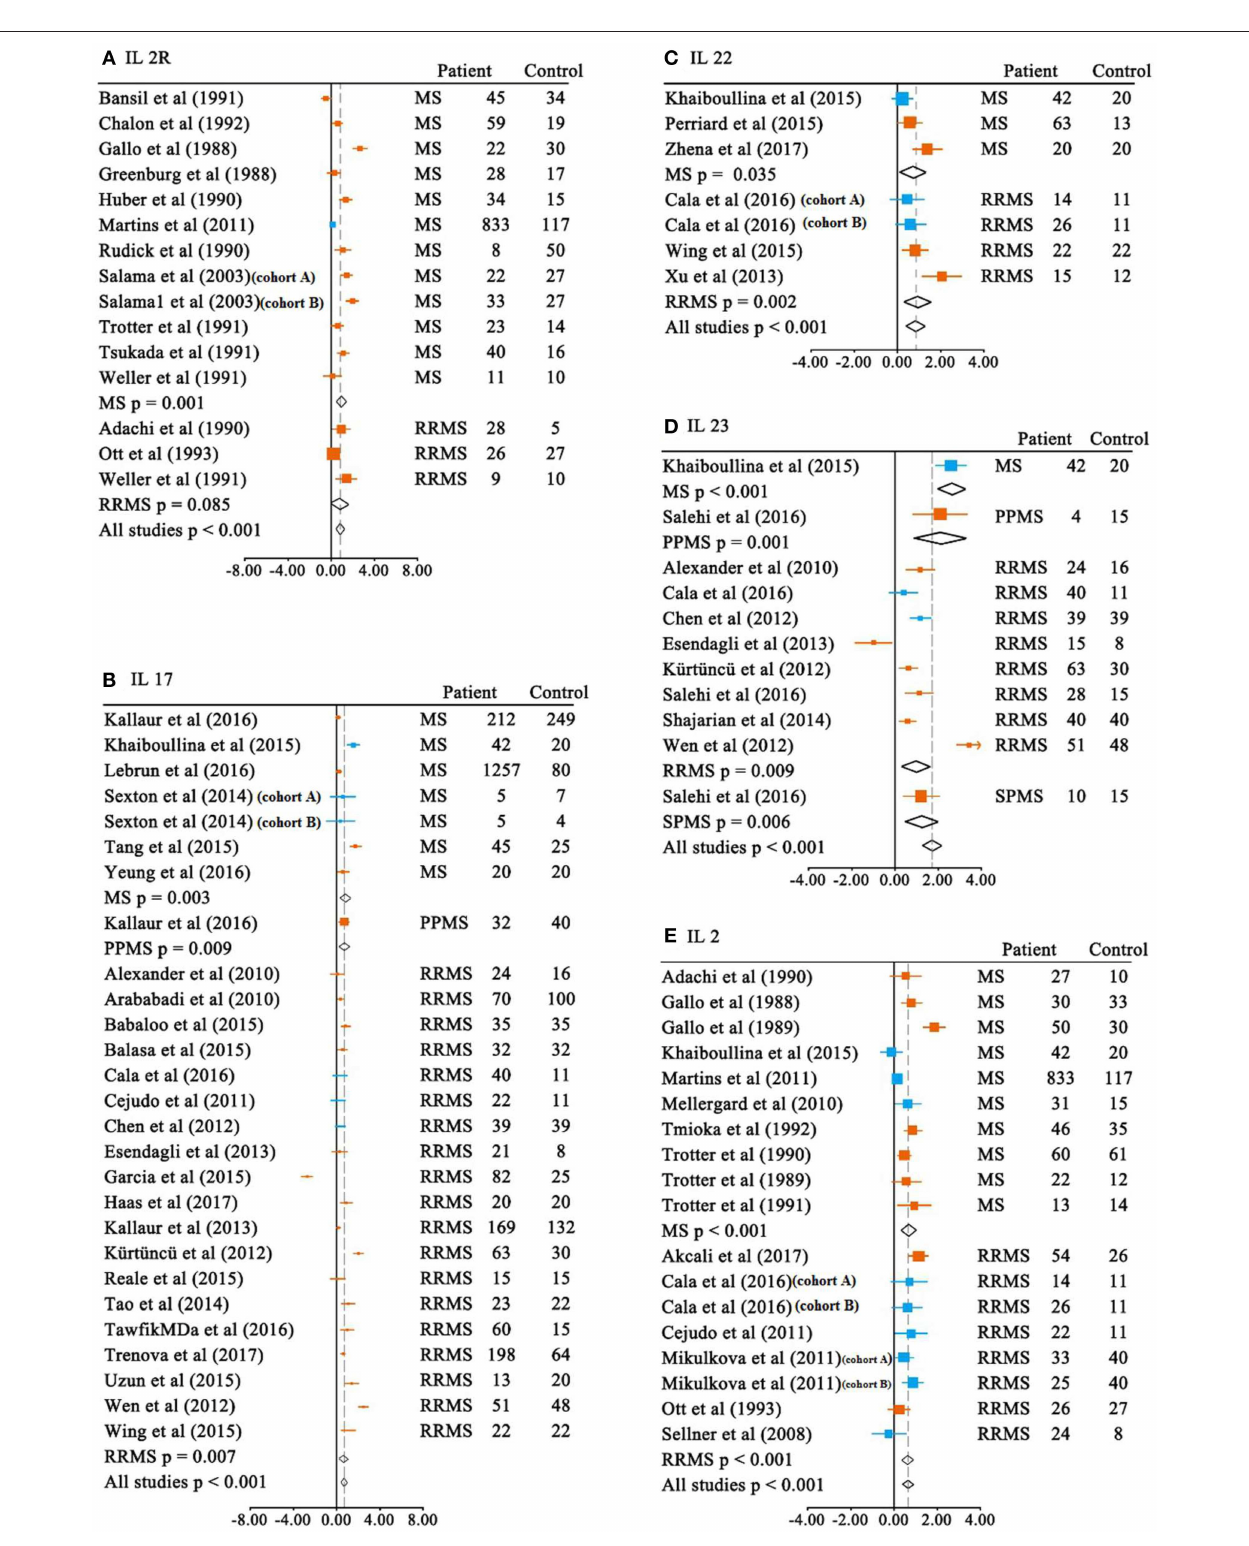
FIGURE 2 | Multiple sclerosis to control SMD for blood cytokines. Blood SMDs of IL-2R (A) , IL-17 (B) , IL-22 (C) , IL-23 (D) , IL-2 (E) between multiple sclerosis and controls. Note that the subtypes of the MS are presented in the figures unless the included studies in the meta-analysis did not provide the information. MS, multiple sclerosis; RRMS, relapsing-remitting MS; PPMS, primary progressive MS; SPMS, secondary progressive MS; SMD, standardized mean difference; ELISA;